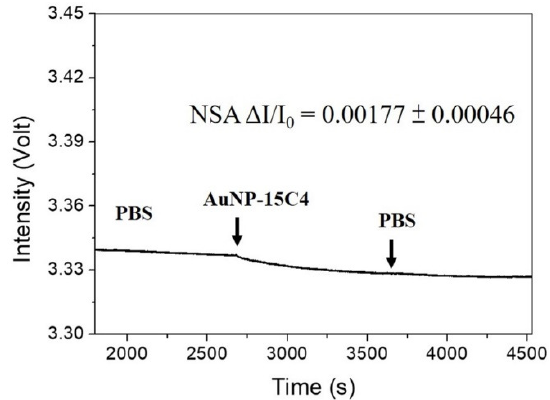
Figure 5. Real-time sensorgram showing the NSA responses of a sensing fiber upon injection of an AuNP@Ab D solution (~2.5 nM), and then a PBS solution. AuNP@Ab D solution (~2.5 nM), and then a PBS